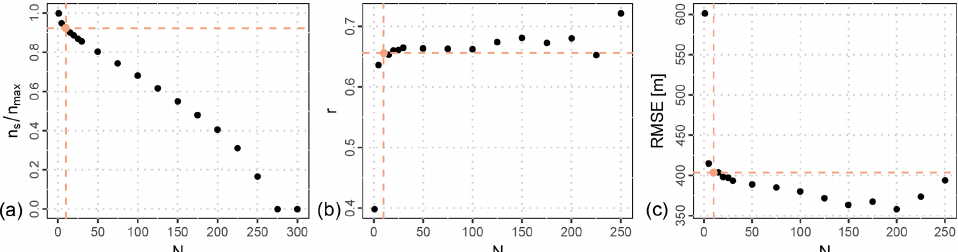
Figure 5. Evaluation of the minimum number of valid pixels N within a cloud layer detected by MISR for the year 2008. (a) The normalized number of events n s for which z base and ˆ z base could both be retrieved. n max is the maximum number of events, which is found for N = 1. n max (b) The linear correlation coefficient r between z base and ˆ z base . (c) The RMSE between z base and ˆ z base . MISR z base is retrieved using the 15th percentile of the z distribution for a 10km radius around the individual ceilometer measurements. The chosen value for N is highlighted in orange. For further details, see text.